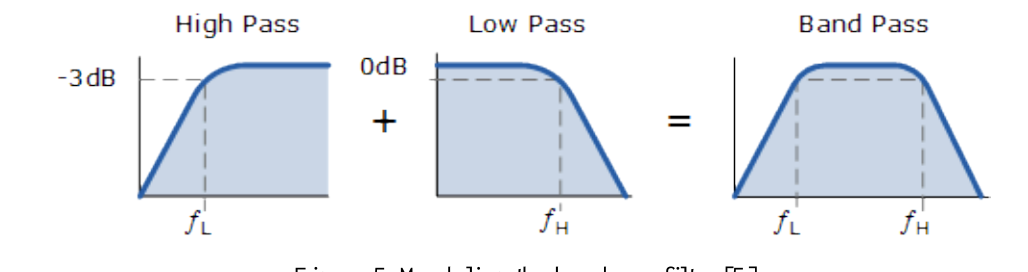
Figure 5. Modeling the bandpass filter [5]